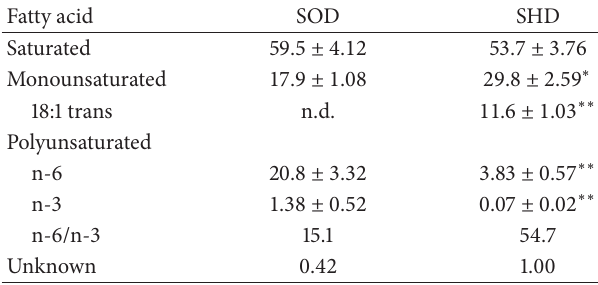
Table 4: Fatty acid composition of stomach content in pups on day 8 after birth nursed by dams fed the soybean oil or shortening